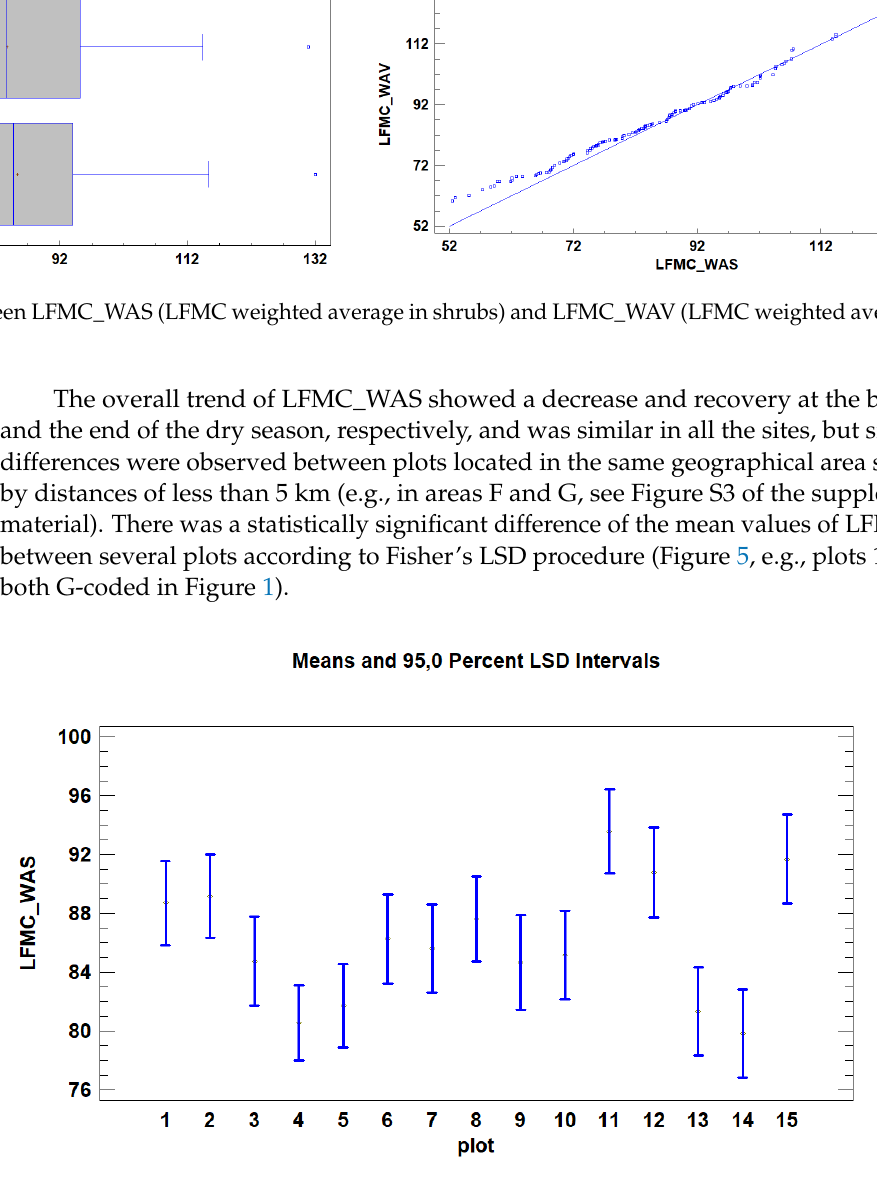
Figure 5. Mean and 95% Fisher’s LSD intervals of LFMC_WAS for the different field